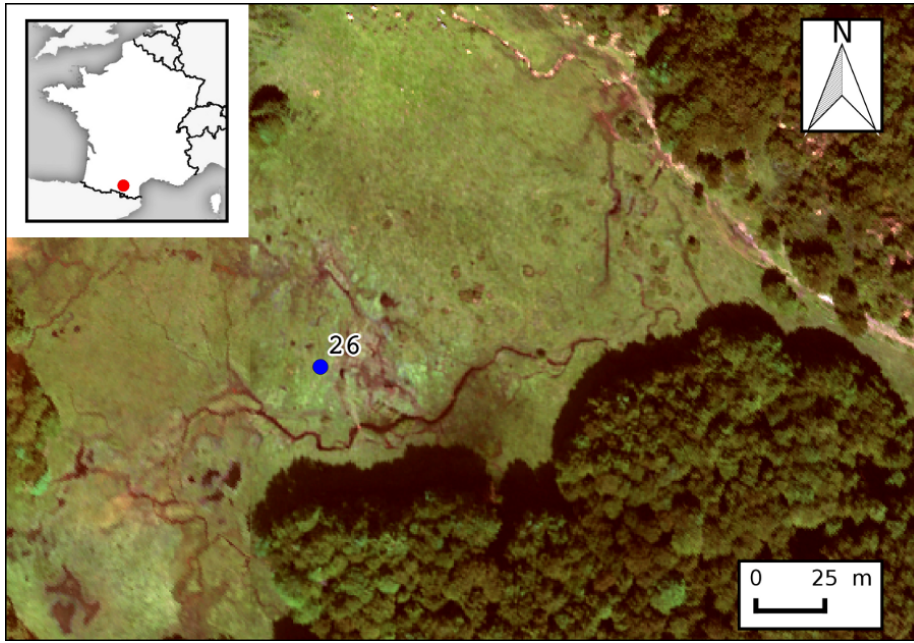
Figure A21. Location of the in situ spectroradiometer measurements for the plots of Aquatic type c (AQ_C).